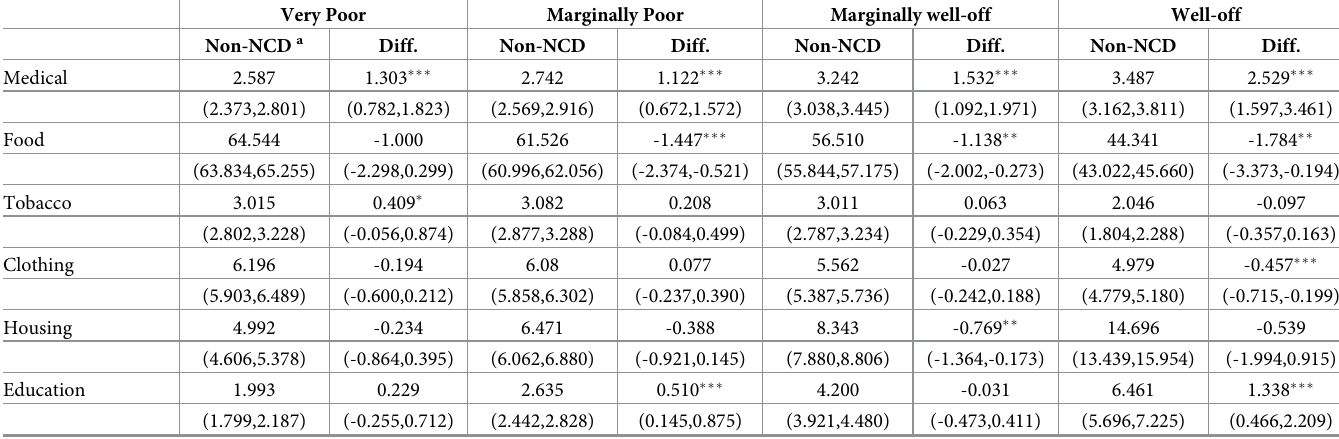
Table 3. Unadjusted differences in expenditure categories between NCD and non-NCD households, by household